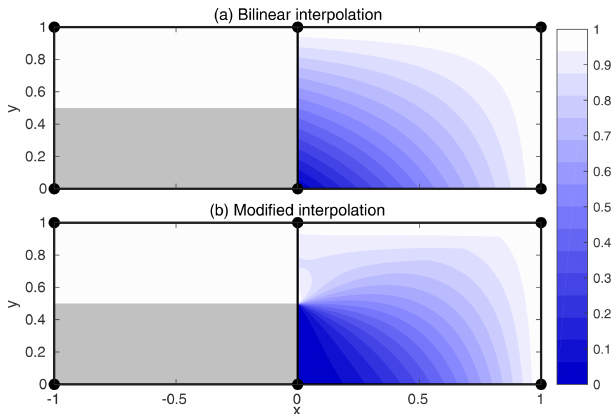
Figure 4. Illustration of modified linear interpolation near corners. In (a) , linear interpolation results in an interpolated velocity field that does not respect the boundary conditions along 0 < y < 0 . 5 and a discontinuous interpolated field at 0 . 5 < y < 1. In (b) , modifying the linear interpolation with a corner solution results in a field that respects the boundary